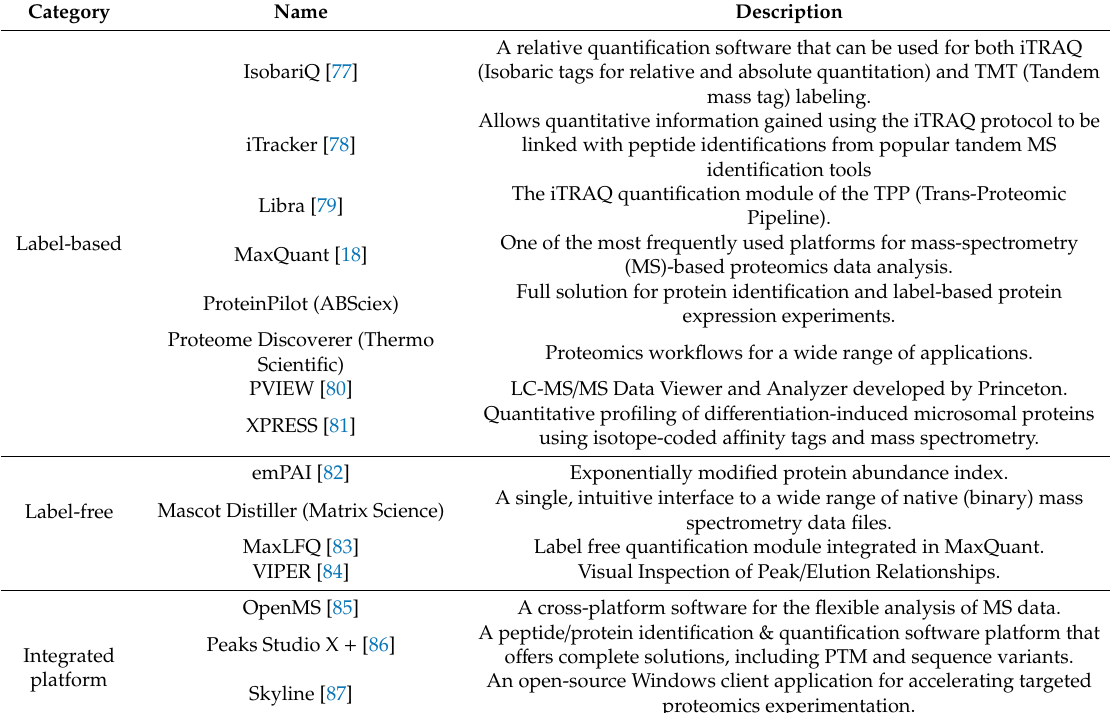
Table 2. Commonly used software package for quantitative